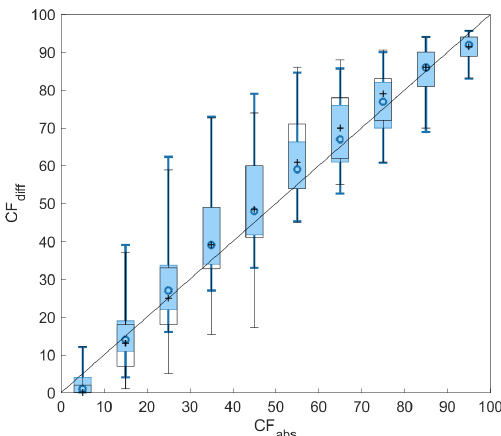
Figure 9. Comparison of the cloud fraction estimates deduced from the two thresholding processes over a set of more than 13000 im- ages taken during 1 year (black) at any time of the day and (blue) only during midday (between 09:00 and 15:00UTC). CF diff as a function of CF abs is shown by box plots changing with bins of CF abs values at 10% increments. Boxes represent the 25th–75th percentile interval, and the vertical lines show the limits of the 5th and 95th percentiles. The symbol in the box stands for the